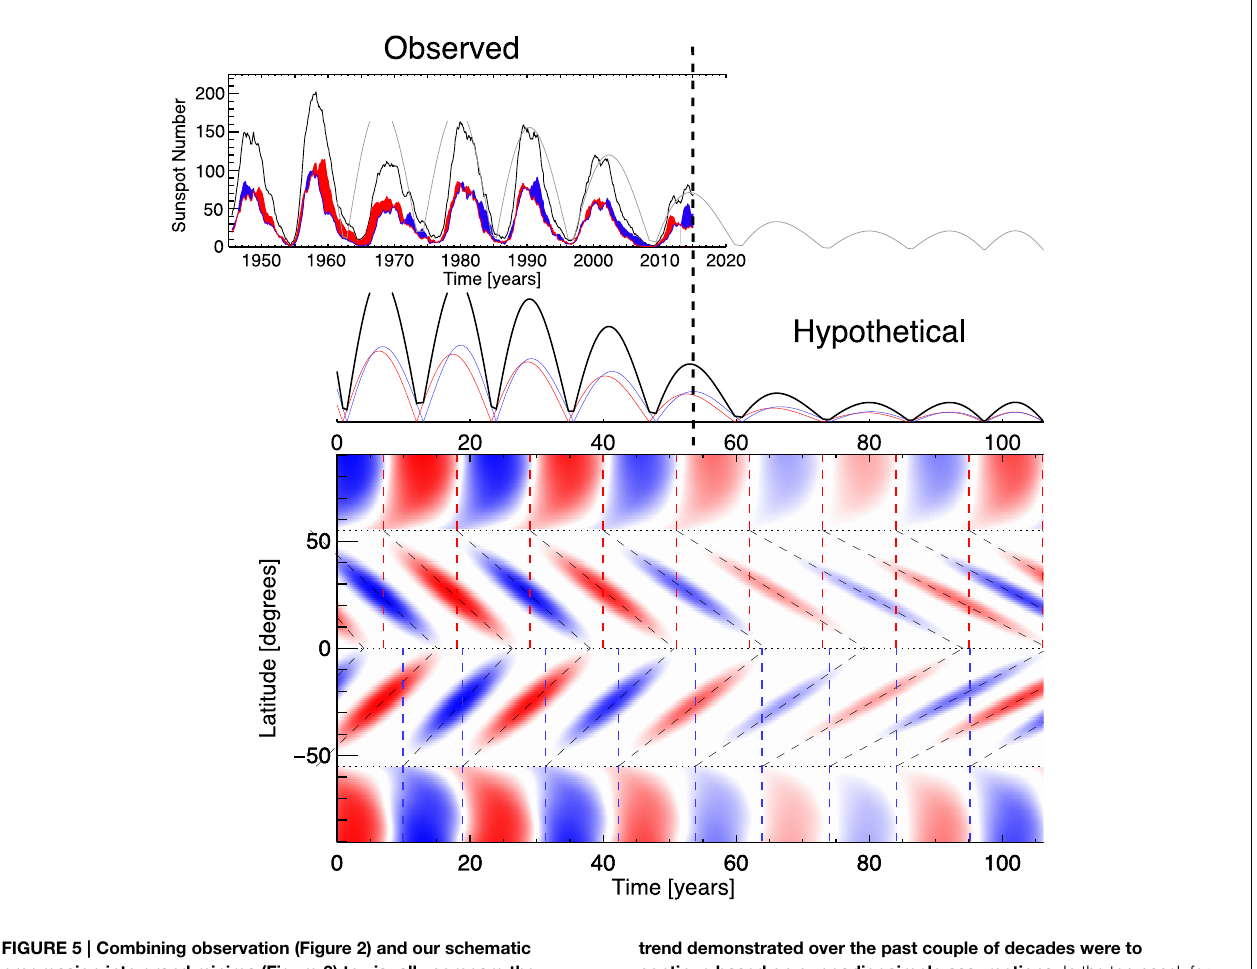
trend demonstrated over the past couple of decades were to continue based on our earlier simple assumptions. In the top panel, for visual comparison we show the cartoon progression of the total sunspot number as a thick dashed gray